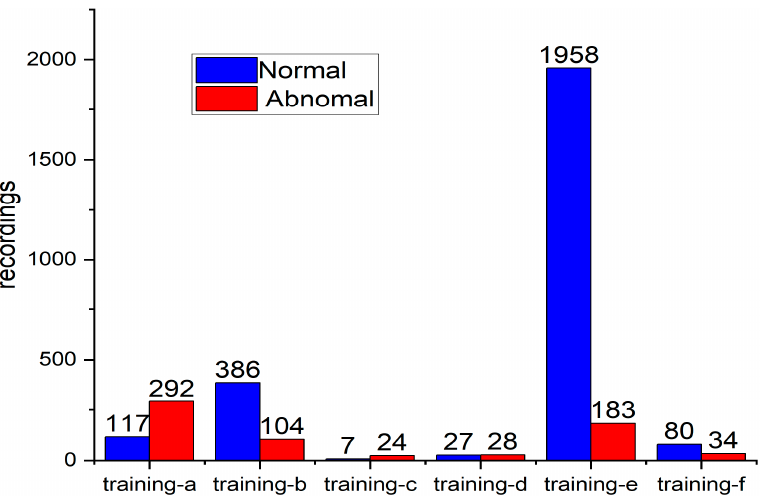
Figure 1. Normal and abnormal samples in each training set.